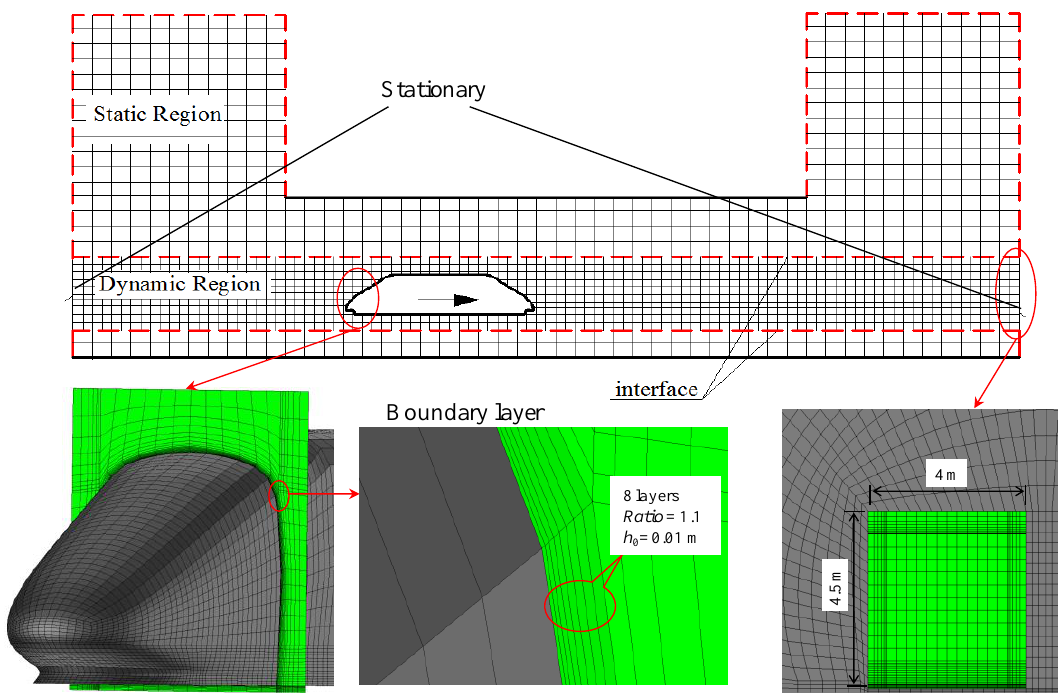
Figure 7. Schematic diagram of mesh model.